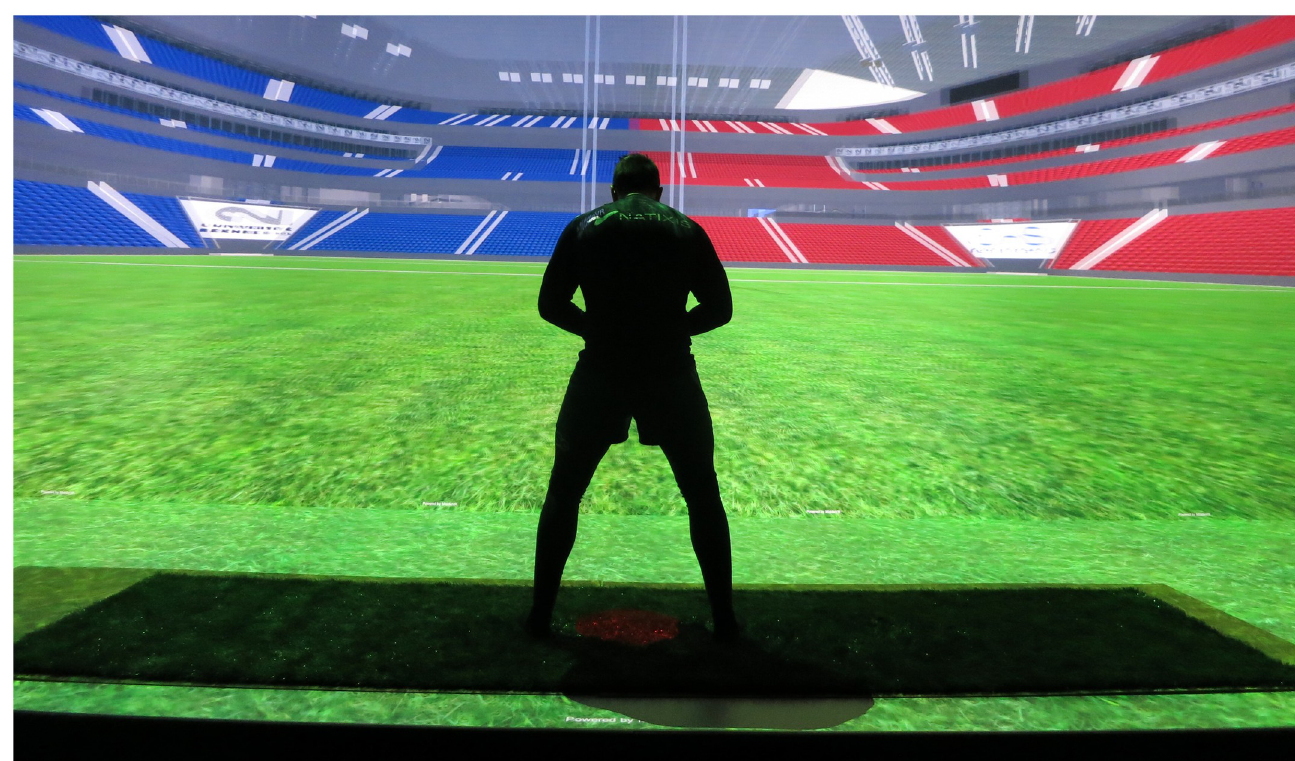
Fig 1. Immersed participant. Third person perspective of a participant immersed within the virtual